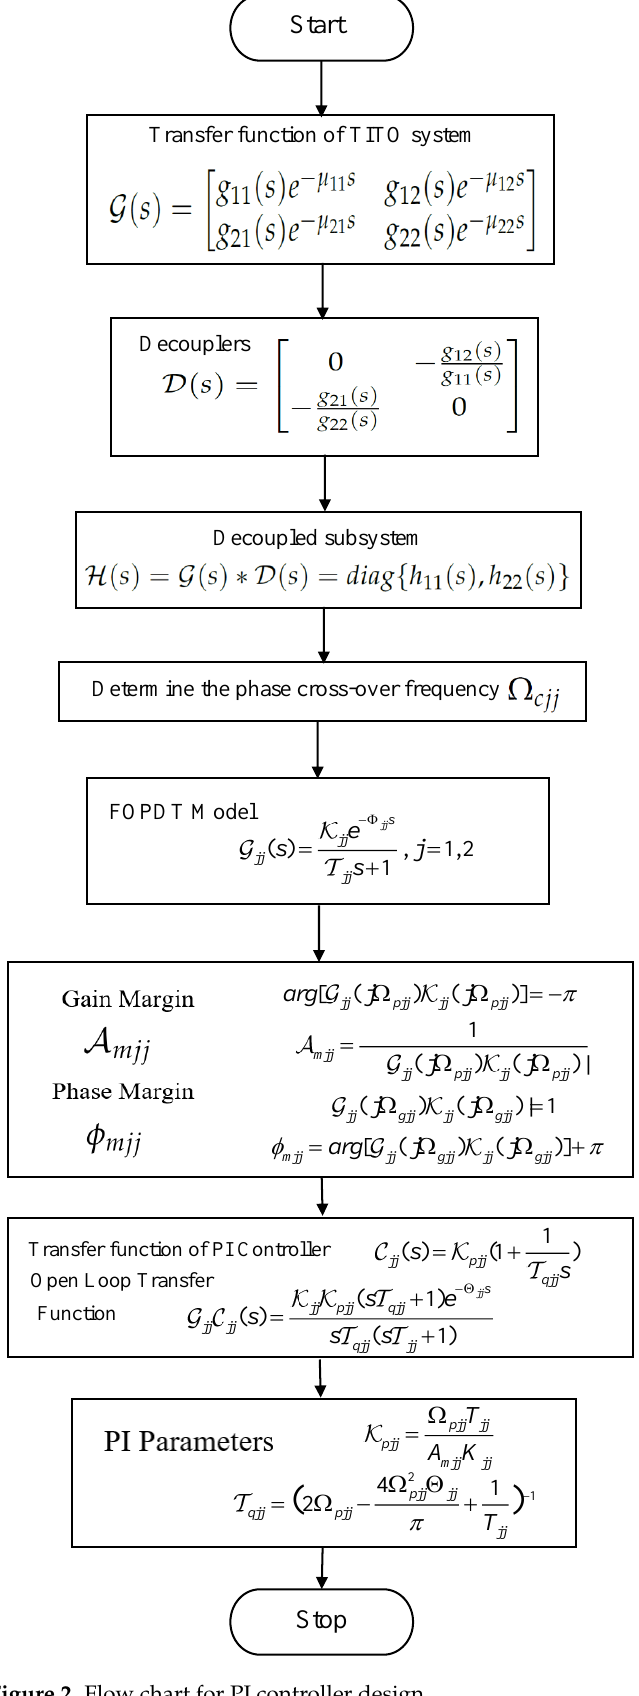
Figure 2. Flow chart for PI controller